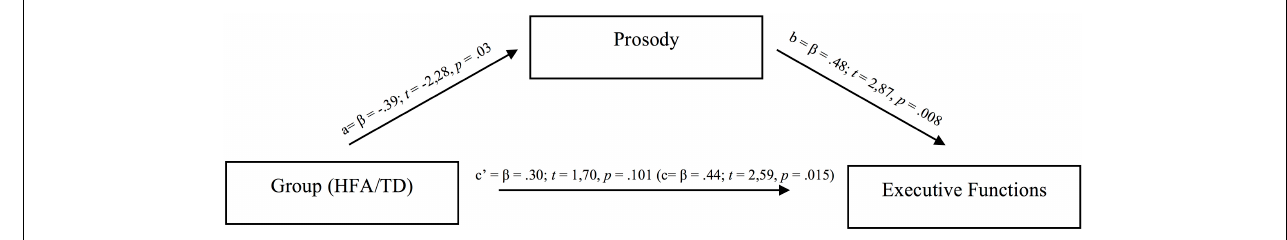
FIGURE 4 | Illustration of mediation analysis (path a = relation between Group and Prosody; path b = relation between Prosody and Executive Functions; path c’ = absence of remaining relation between Group and Executive Functions once Prosody has been added as a mediating